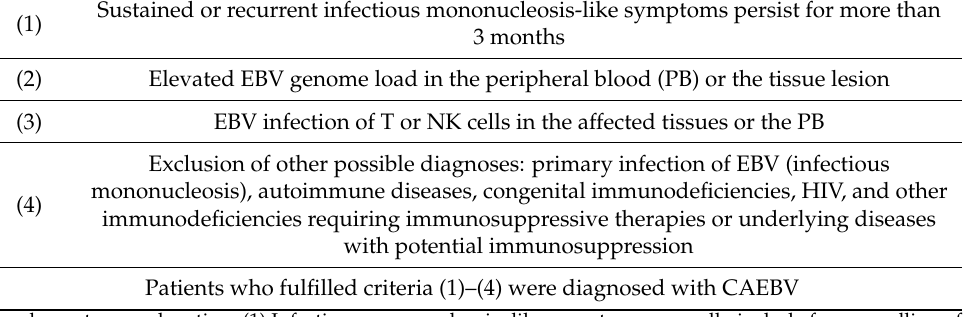
Table 2. Diagnostic criteria of Chronic active Epstein-Barr virus